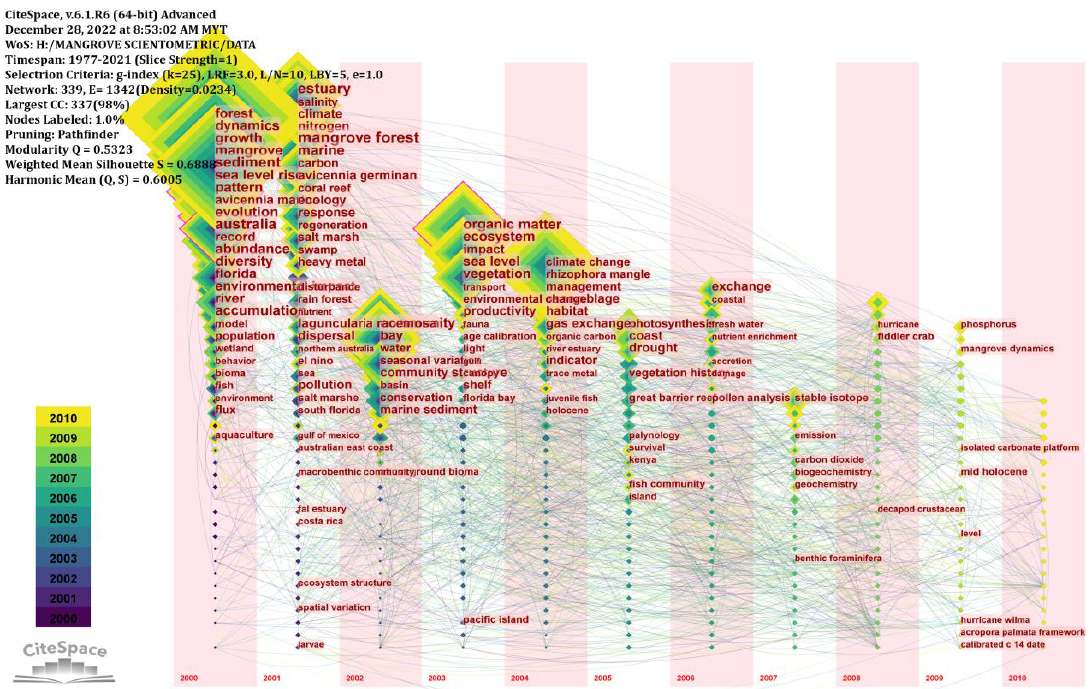
Figure 11. Keyword co-occurrence network from 2000 to 2010 for mangrove and climate change- related publications.